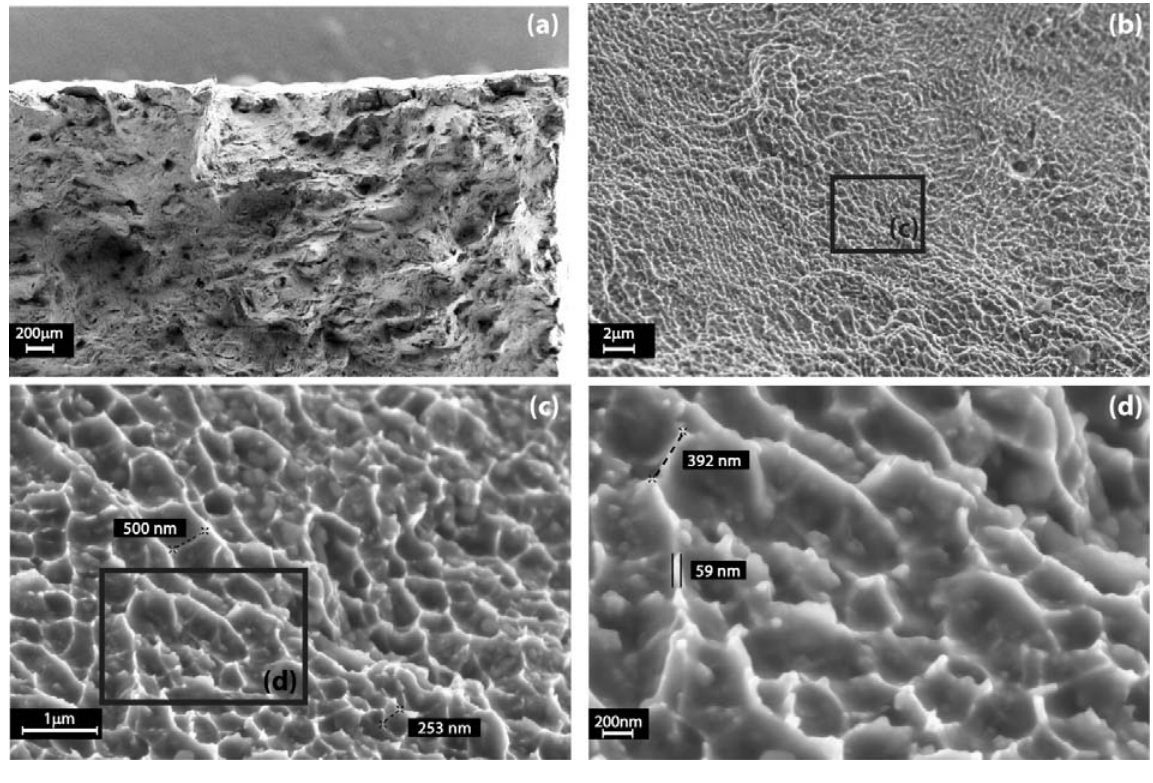
magnifications: ( a – d ) it is covered by sub-micrometric voids and dimples with a nanometric